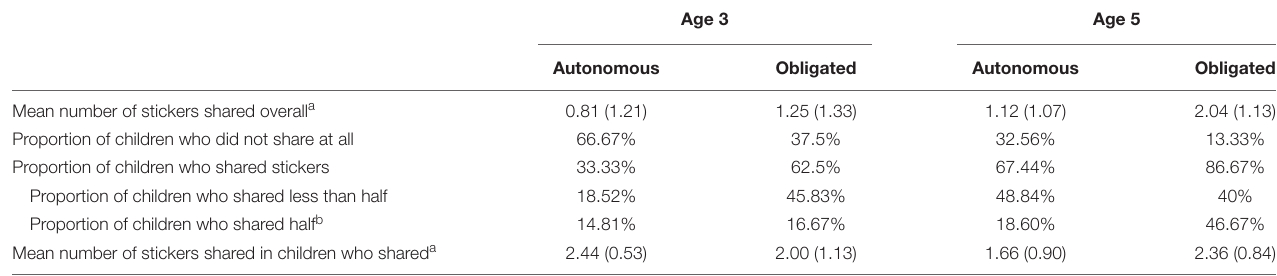
TABLE 1 | Means (standard deviation in parentheses) of children’s sharing behavior as a function of age and condition.